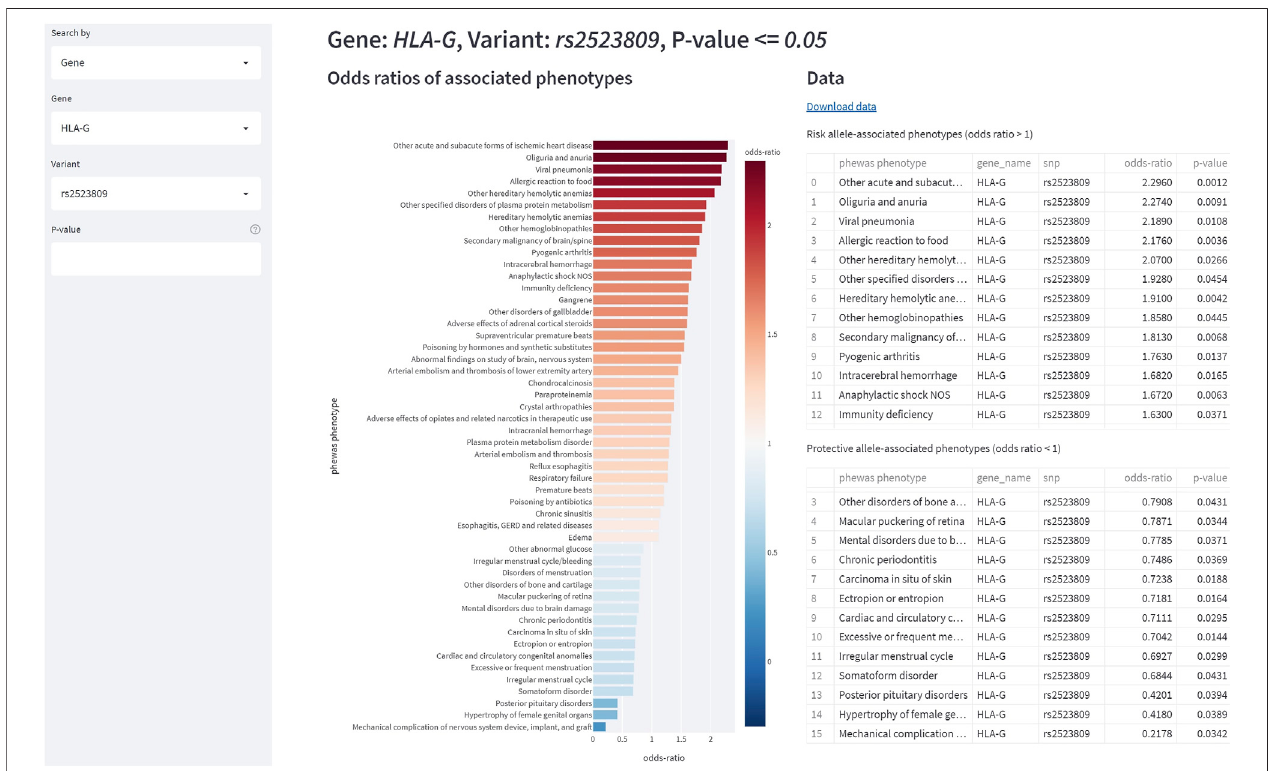
FIGURE 2 | The StarGazer interface after searching “ HLA-G ” in Gene mode. At p = 0.05, the fi rst allele returned is rs11206510. The color-coded bar chart shows the odds ratio of association of the allele with each phenotype. The table on the right is the same data tabulated which can be downloaded as a csv fi le. The StarGazer Variant mode is similar in